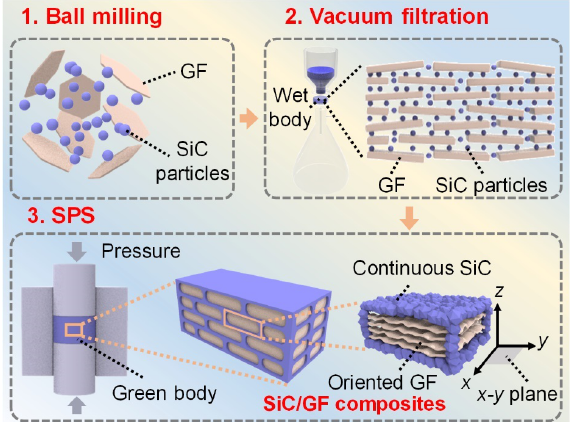
Fig. 2 Schematic illustration of the fabrication process of SiC/GF